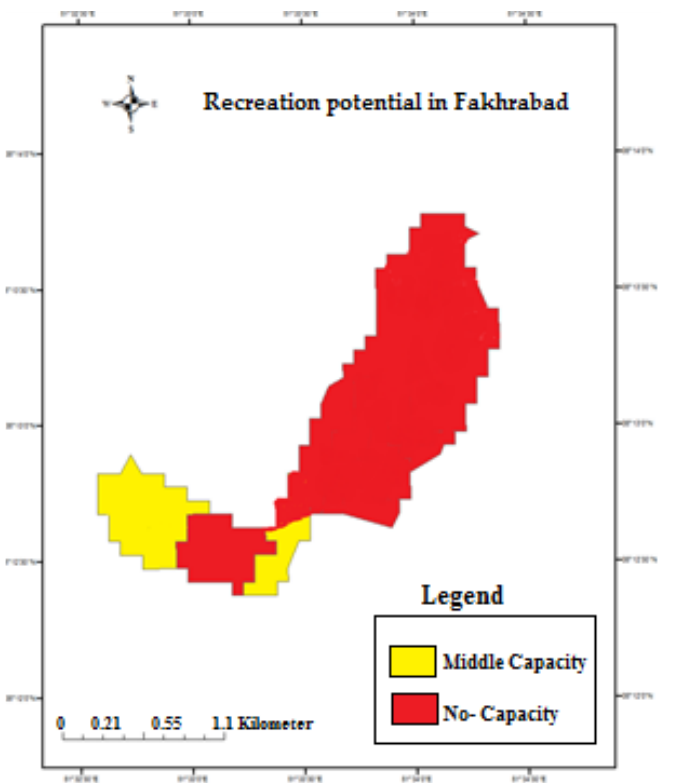
Figure 6. Recreation potential calculated with multicriteria evolution. Recreation potential among high capacity (category 1: green polygon), middle capacity (category 2: yellow polygon), and no capacity (red polygon).